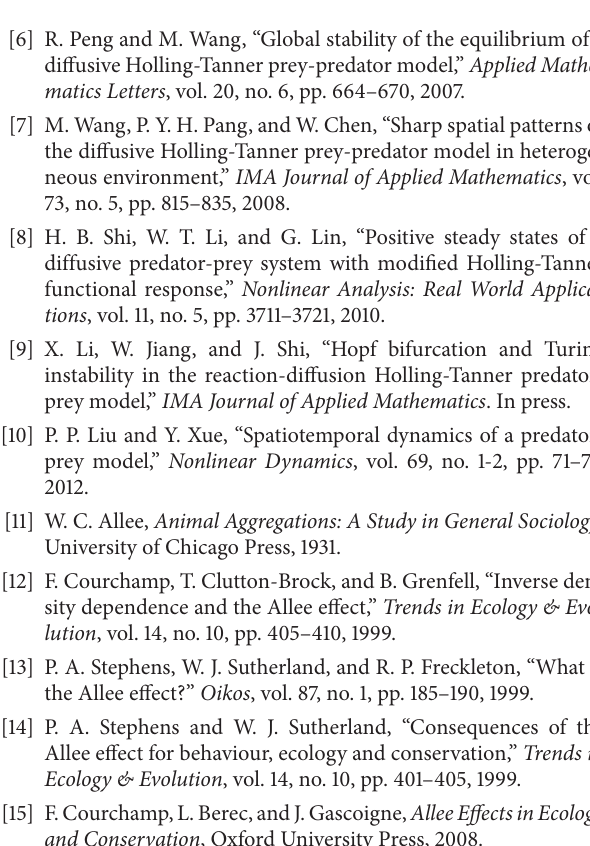
when the conditions on the parameters are satisfied, 𝐸 ∗ = (𝑢 ∗ , 𝑣 ∗ ) is stabilized under arbitrary spatially